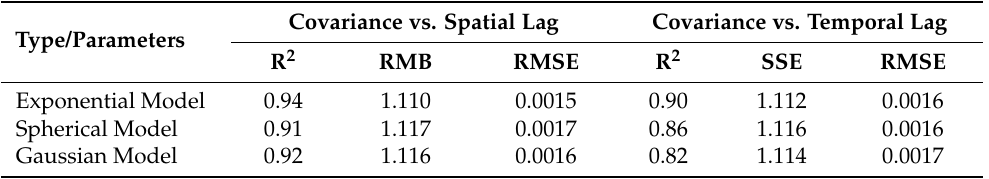
Table 2. Fitting results of the experimental covariance for the spatial and temporal lags based on three classical models (exponential, spherical, and Gaussian